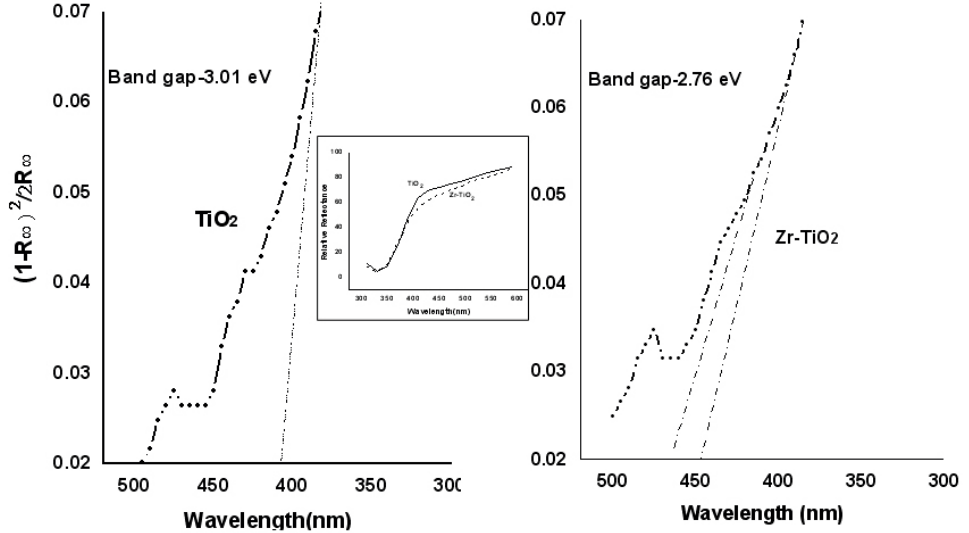
The misplaced Figure 5 in the original article should be replaced with the following